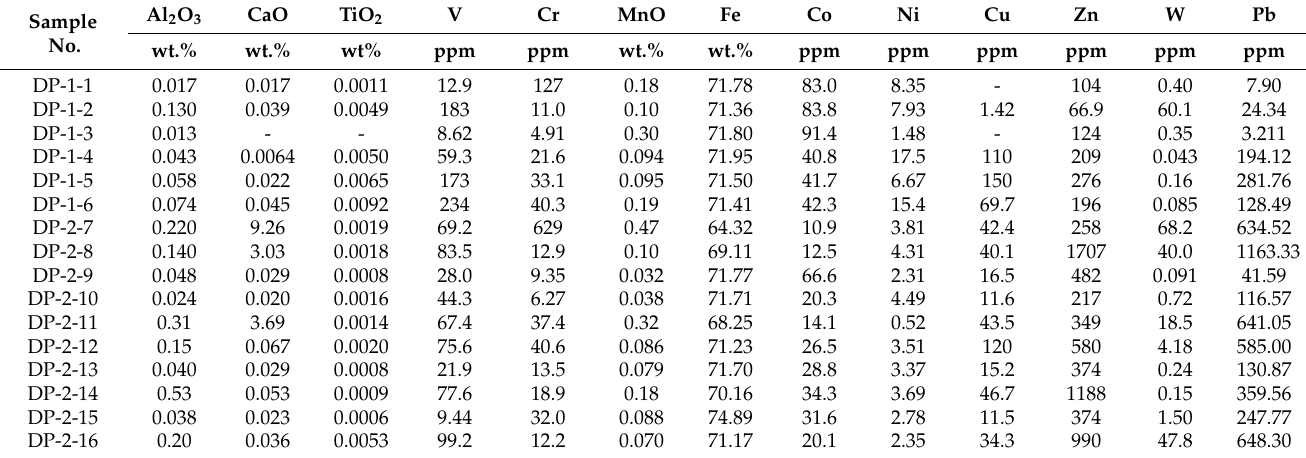
Table 2. Selected LA-ICP-MS analyses of magnetite grains from the Dongping deposit.